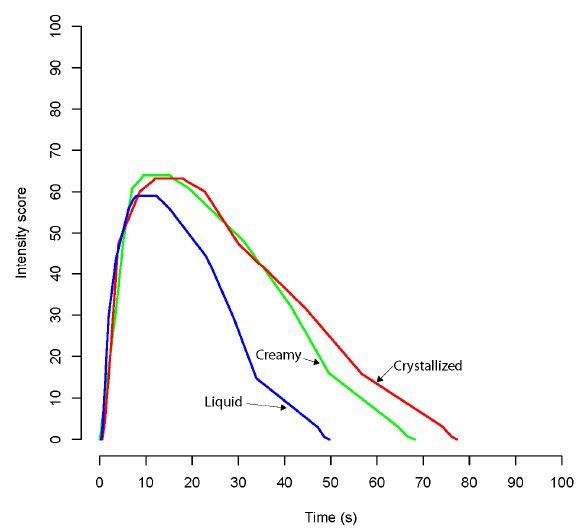
Figure 3. Time intensity curves for citrus honey samples.